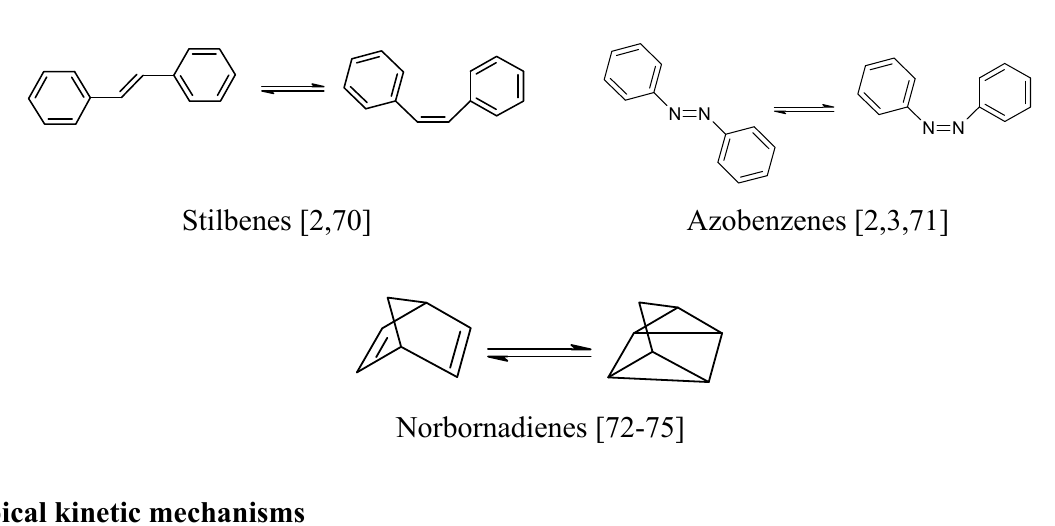
Figure 3. Some non-chromic AB